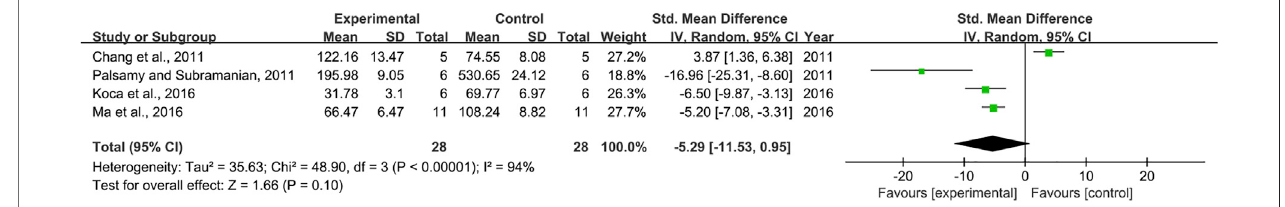
FIGURE 10 | Pooled estimate of TNF- α with RSV.